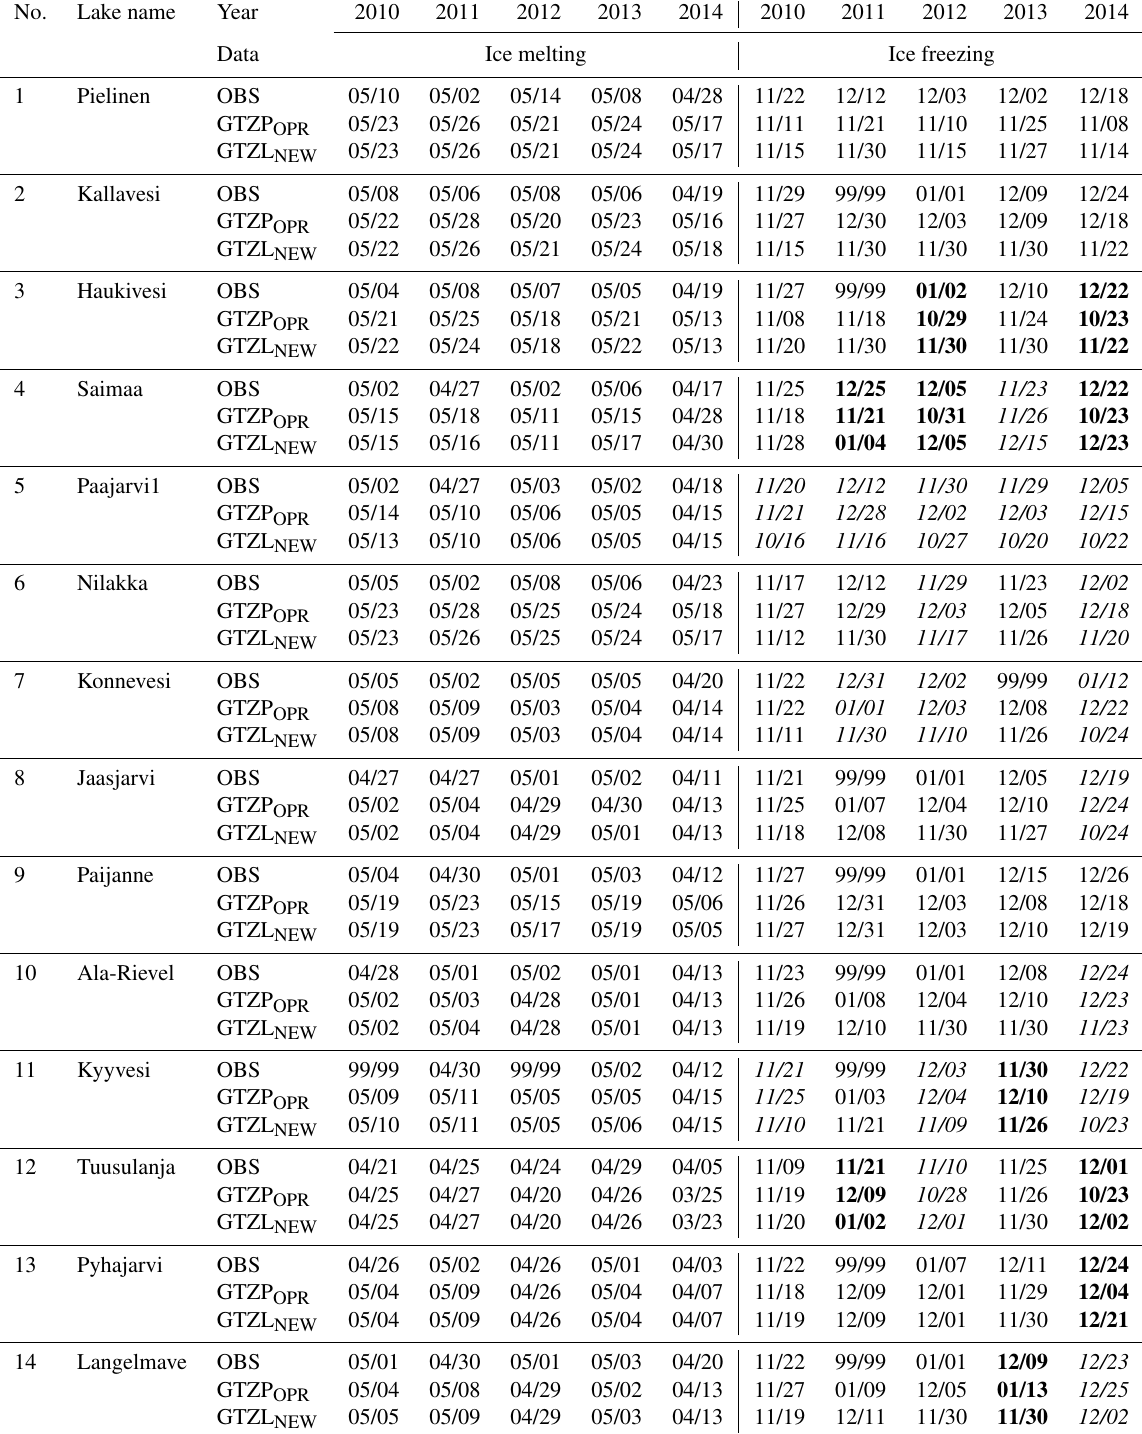
Table 4. Ice formation/disappearance dates for 2010–2014 of 27 verification sites; OBS – measured by SYKE; GTZP OPR and GTZL NEW – ECMWF experiments with operational and updated D water respectively; improvements in the freeze-up date in GTZL NEW compared with GTZP OPR are marked in bold and degradation in italics (only cases when the difference was larger than 14d).